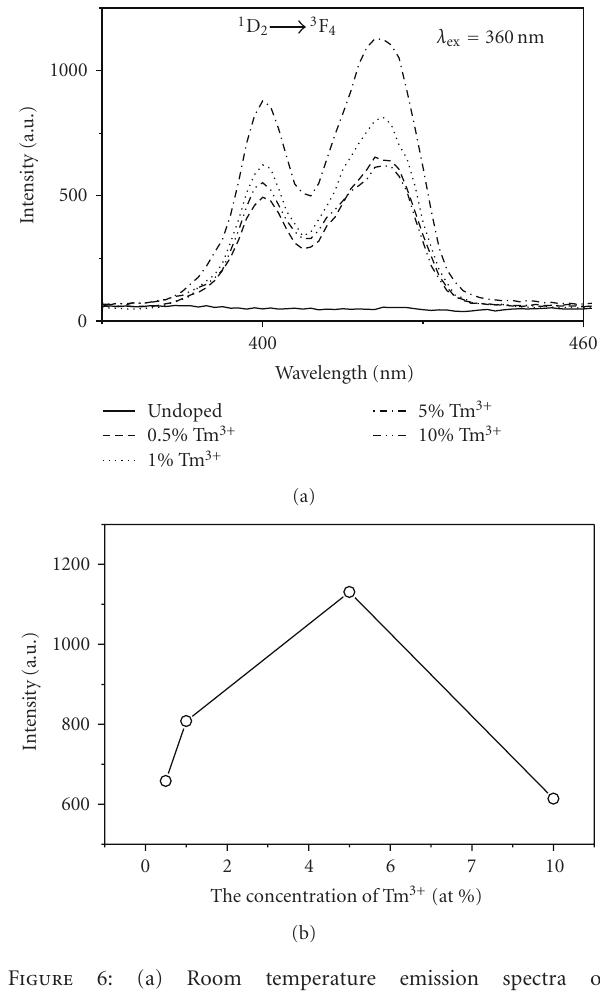
Figure 6: (a) Room temperature emission spectra of LiIn 1 − x Tm x (WO 4 ) 2 ( x = 0, 0.5, 1, 5, and 10 at.%), excited at 360nm wavelength. (b) Integrated emission intensity of → 3 F 1 D 2 4 transition (447nm) in LiIn(WO 4 ) 2 as a function of Tm 3+ concentration.